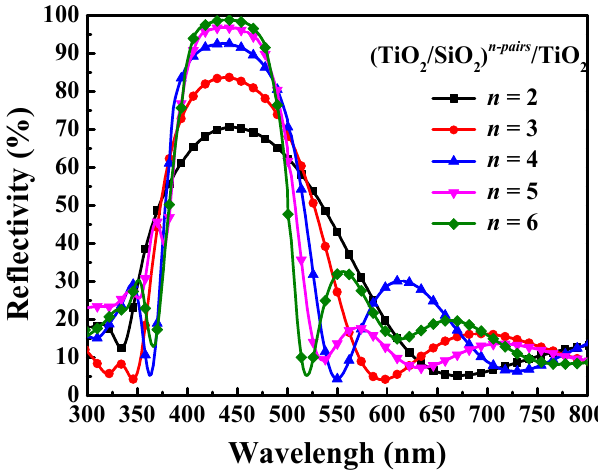
Figure 5. The reflectivity spectra of the (TiO 2 /SiO 2 ) n-pairs ( n = 2, 3, 4, and 5)/TiO 2 distributed Bragg reflector (DBR) structure.